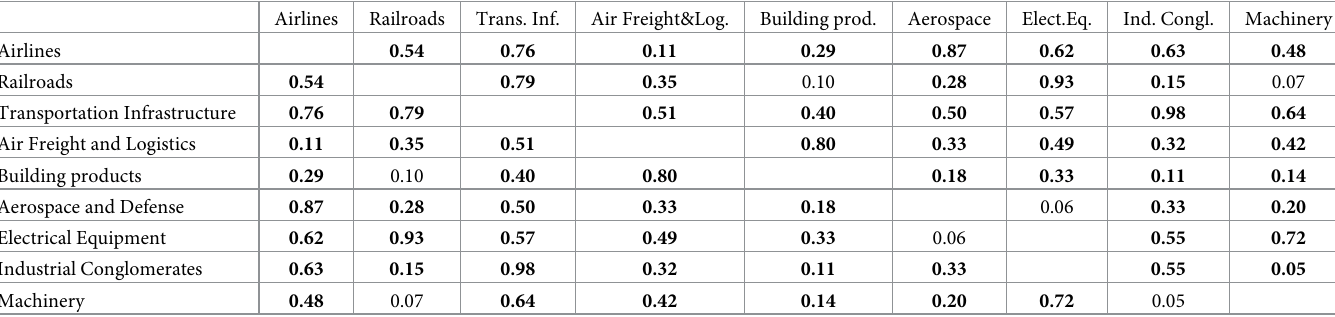
Table 11. Industrials